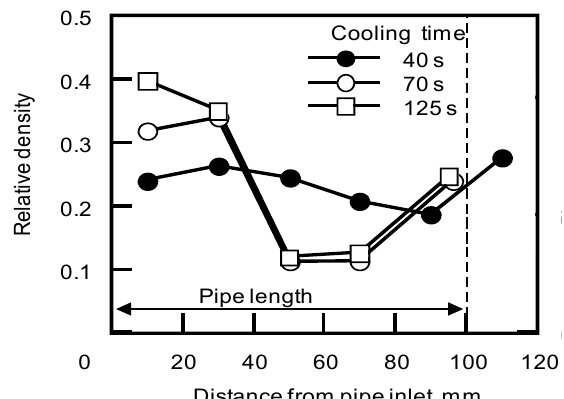
Figure 3. Distribution of relative density within Al